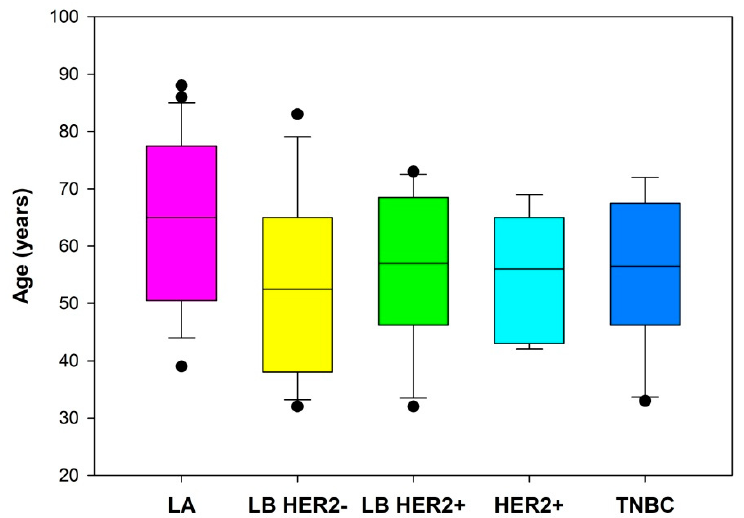
Figure 2. Age of patients with specific breast cancer subtypes. LA = luminal A; LB HER2 − = luminal B without HER2 overexpression; LB HER2+ = luminal B with HER2 overexpression; HER2+ = human epidermal growth factor receptor 2 positive; TNBC = triple negative breast cancer. Horizontal lines represent median (black), the bottom and the top of the boxes rep- resent the upper and the lower quartile, the whiskers represent 10th and 90th percentile, while the solid circles represent the individual data points.